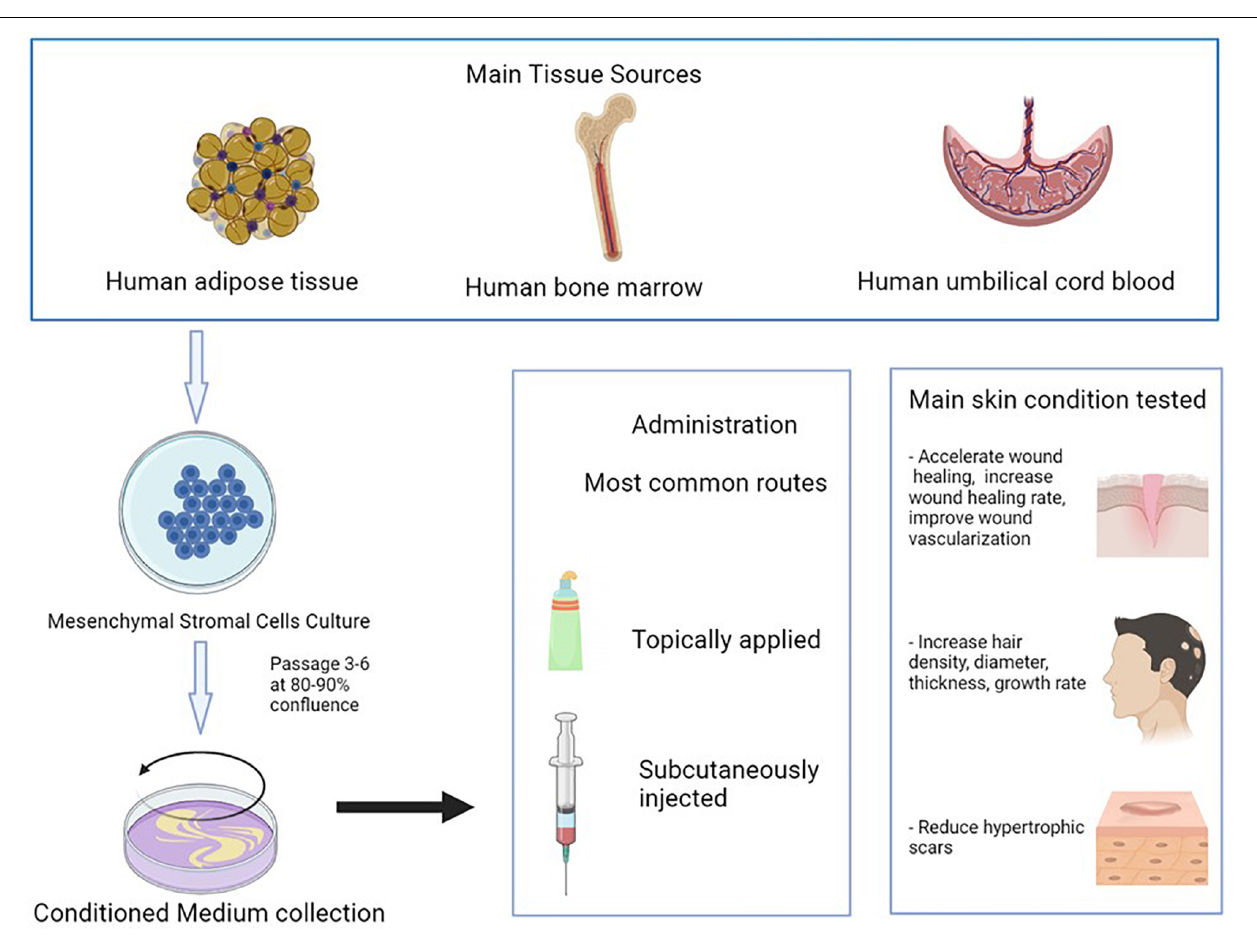
FIGURE 2 | Iconographic summary of this review’s main